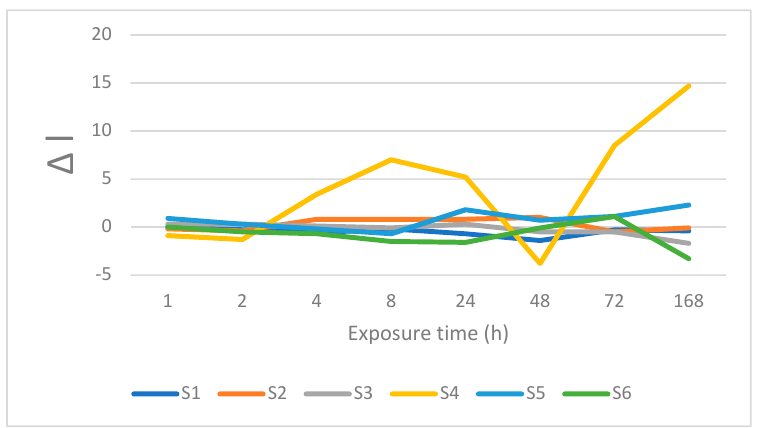
Figure 10. Changes is lightness after immersion in Coca-Cola ® .